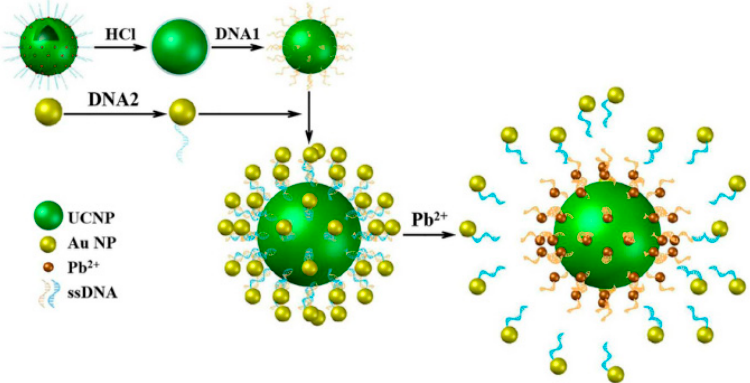
Figure 7. Schematic illustration of a Pb 2+ -detecting sensor with high sensitivity [64].